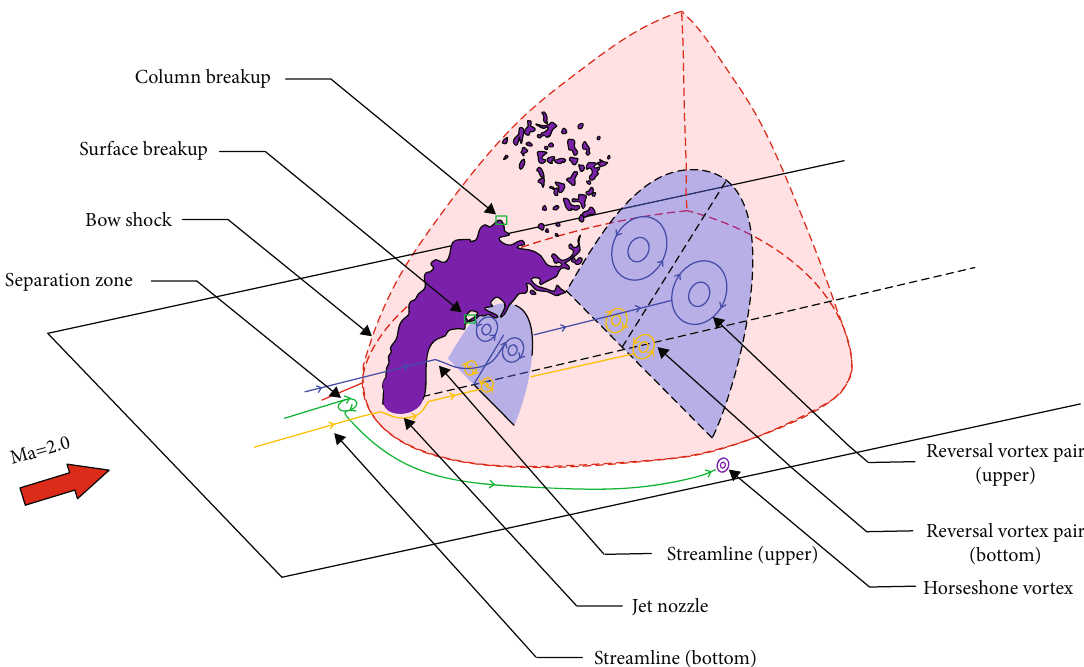
Figure 15: The fl ow fi eld structure of the elliptical liquid jet in supersonic cross fl